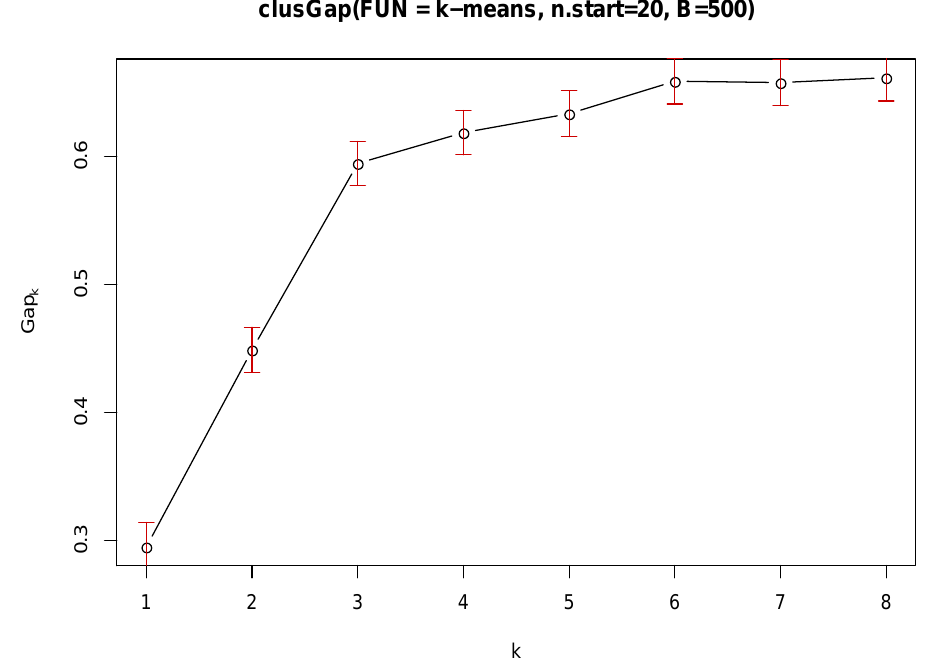
Figure 4. The gap statistics (k—means, Euclidean